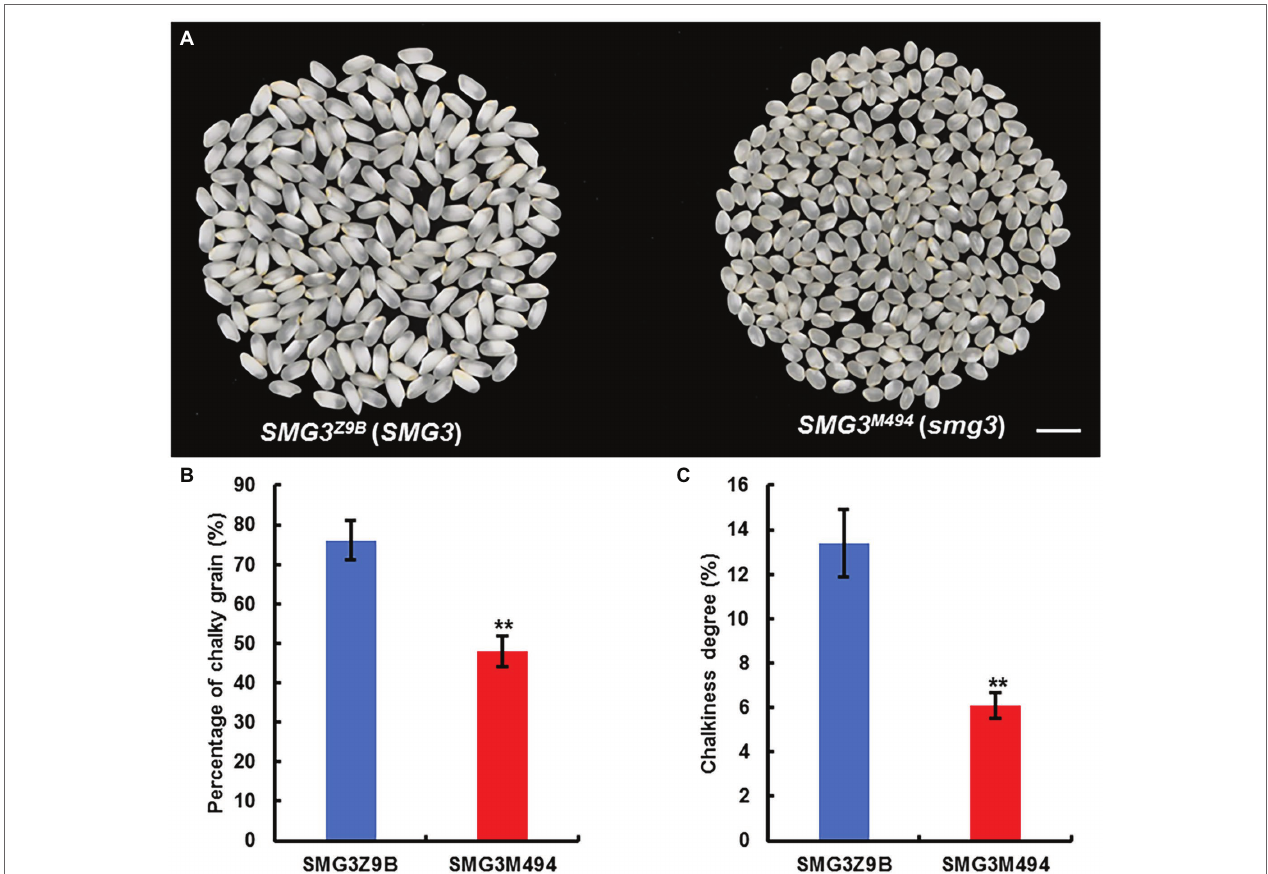
FIGURE 5 | Improved appearance quality of milled rice by introgression of SMG3 allele from M494. (A) Comparison of the appearance of milled rice between NIL- SMG3 Z9B and NIL- SMG3 M494 , carrying the homozygous for Z9B and M494 allele, respectively. Scale bar: 8 mm. (B,C) The percentage of milled rice with chalkiness (B) and the chalkiness degree of milled rice (C) from NIL- SMG3 Z9B and NIL- SMG3 M494 . Data are given as means ± SD. ** Indicates p < 0.01 by Student’s t